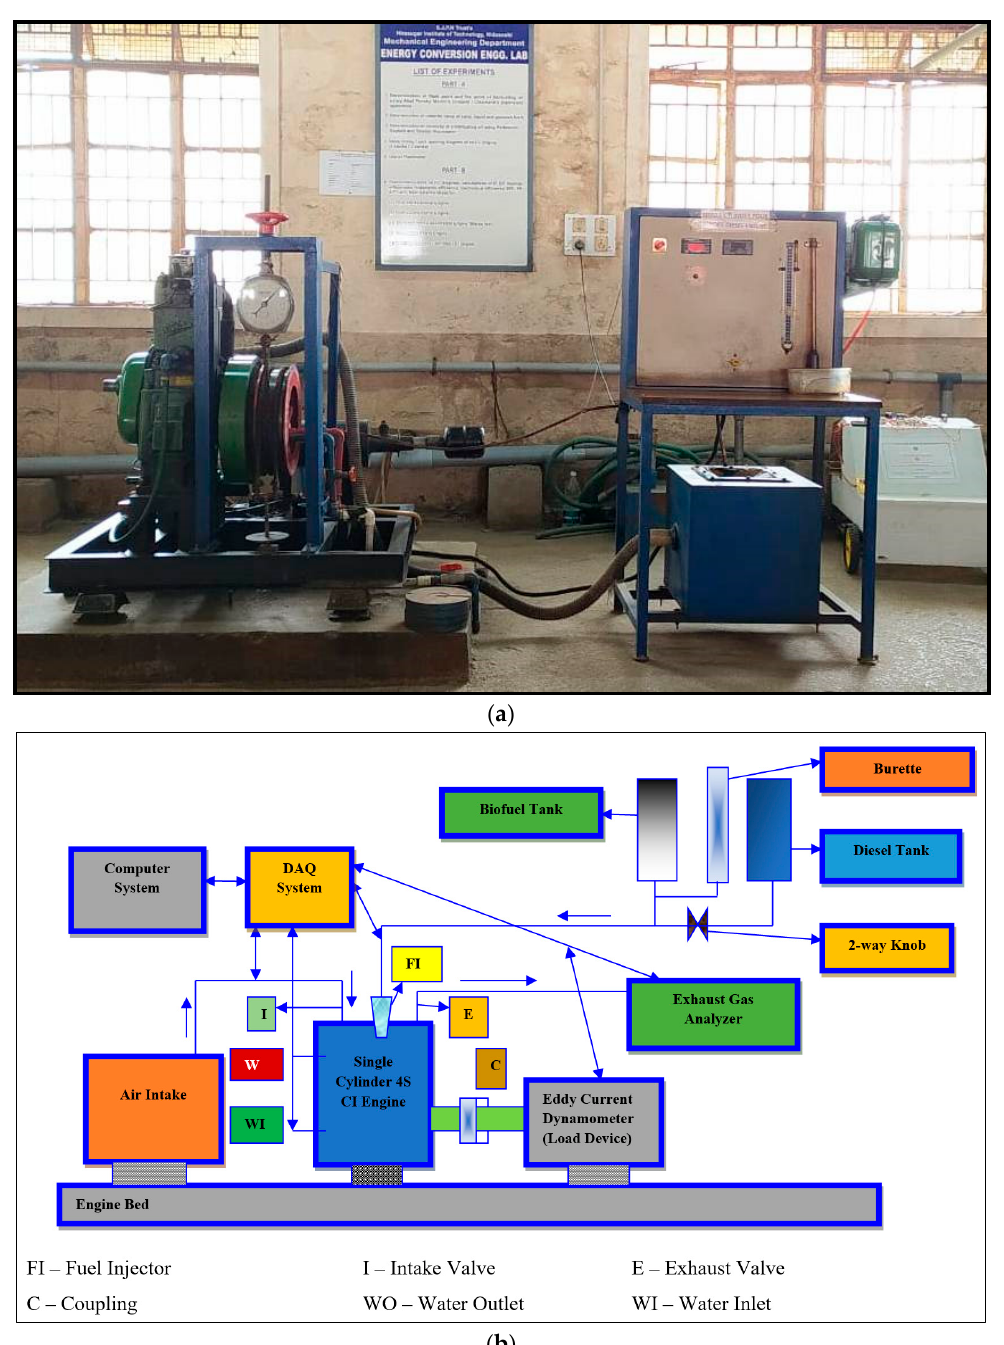
Figure 4. Experimental setup: ( a ) pictorial presentation; ( b ) schematic presentation